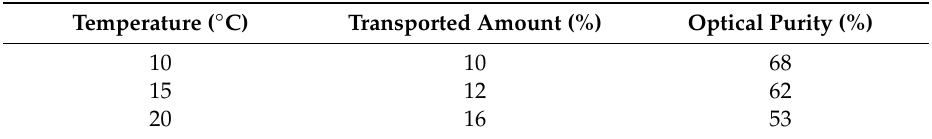
Table 2. The effect of temperature on the transport of racemic acetic acid salt of NEA ( 21 ) after 2 h of transport time using macrocycle ( R , R )- 2 as a carrier.